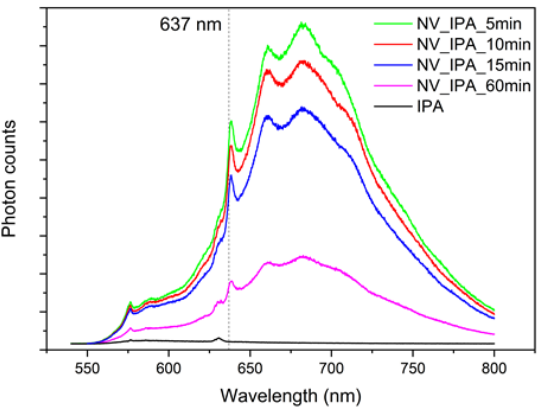
Figure 5. Fluorescence spectra of the NV-rich nanodiamond particles suspended in IPA, after 5, 10, 15, and 60 min of ultrasonic disintegration; the fluorescence spectrum of pure IPA is added as a reference.